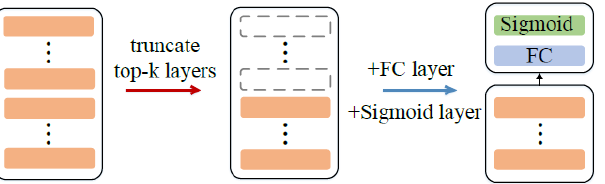
Figure 3. The main stages involved in building a model using truncated BERT for a BTC task. The left is the full BERT model, the middle is the truncated BERT after dropping the top- k Transformer layers of full BERT, and the right is a binary classification model consisting of an encoder (the truncated BERT) and a task-specific head (a fully connected layer followed by a sigmoid layer).